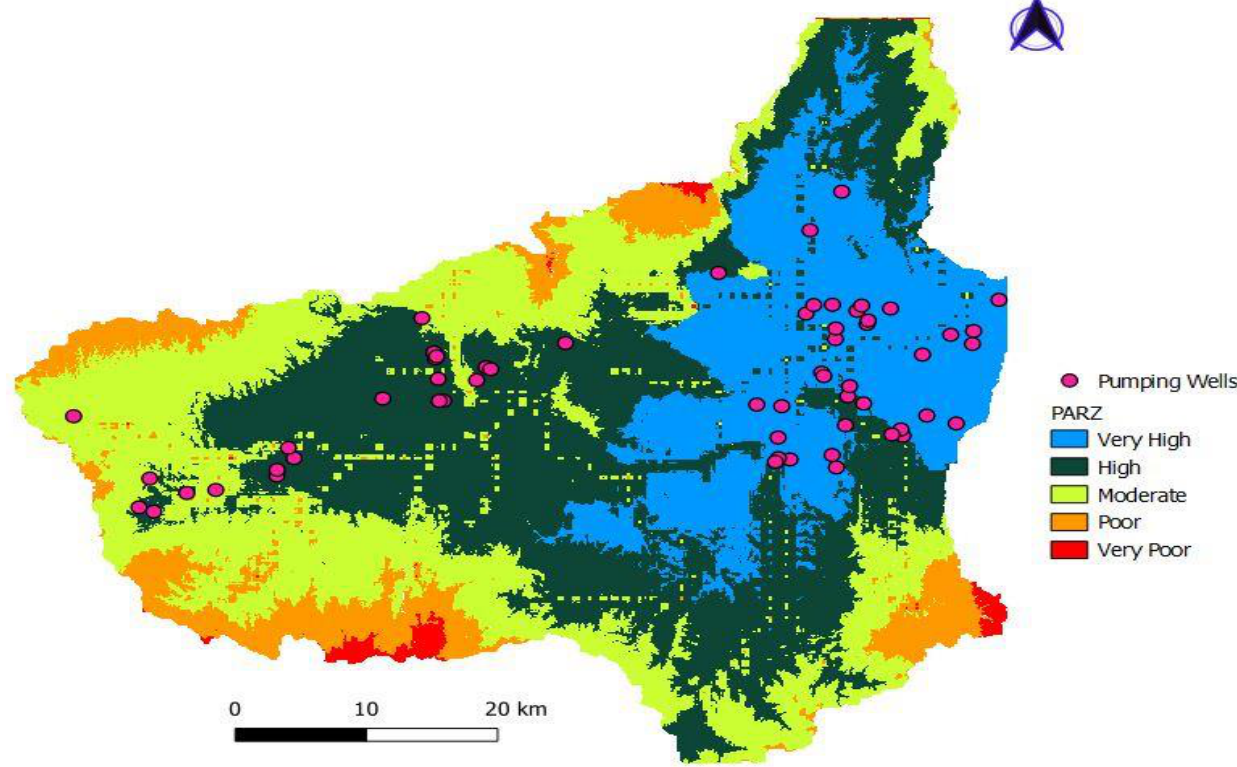
Figure 6. Spatial distribution of potential aquifer recharge zones of the study area.